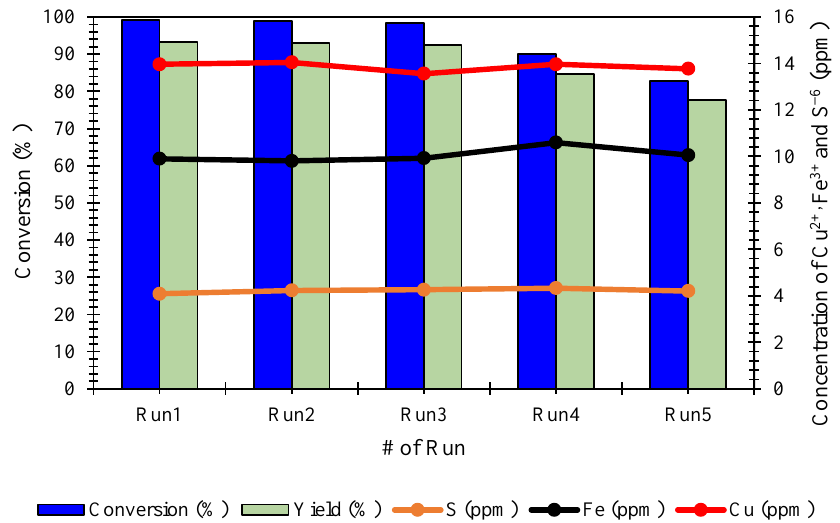
Figure 7. Catalyst reusability at optimum conditions (catalyst loading 2%, 3 h reaction time, temperature 70 °C, with a 15:1 methanol:oil ratio) and active element concentrations in biodiesel. The retention of the high rate of FFA transformation into biodiesel over five reaction cycles was in keeping with the data obtained from FTIR (Figure 8); a unique absorption band at 3466 cm − 1 was acquired from the reaction product which differed from that representing PFAD. This was ascribed to the stretching vibration of C-O in association with the methyl esters. The absorption zeniths noted at 2920 cm − 1 and 2860 cm − 1 reflected the CH-asymmetric vibration whereas the C=O absorption was indicated by an intense band at 1744 cm − 1 . The peaks contained within the 1000–1300 cm − 1 were attributed to the stretching vibration of C-O, implying that the resultant liquid following the reaction was similar in character to biodiesel, being made up of long-chain fatty acid esters [46].